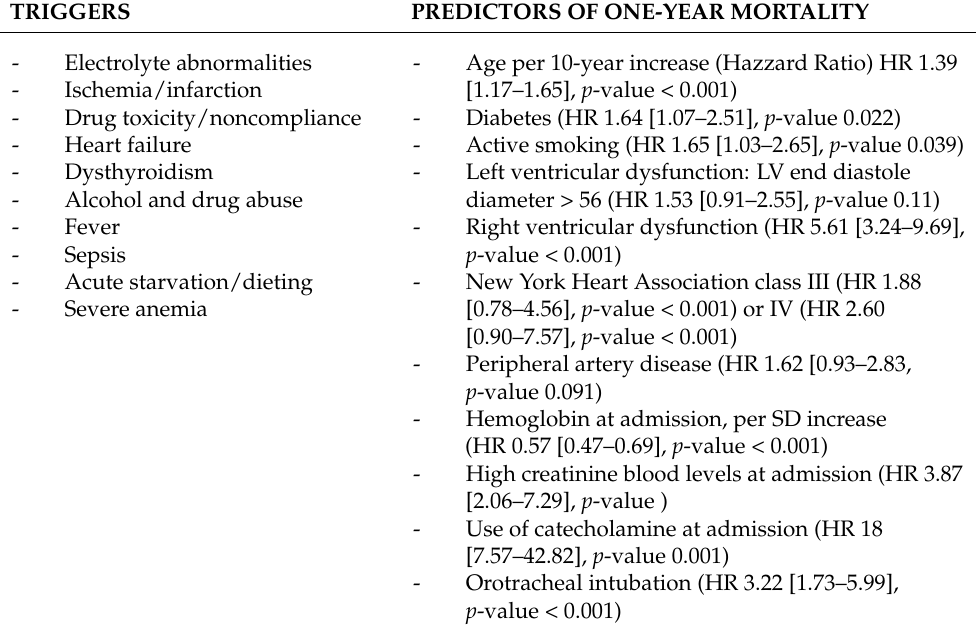
Table 1. Triggers and predictors of one-year mortality of electrical storm